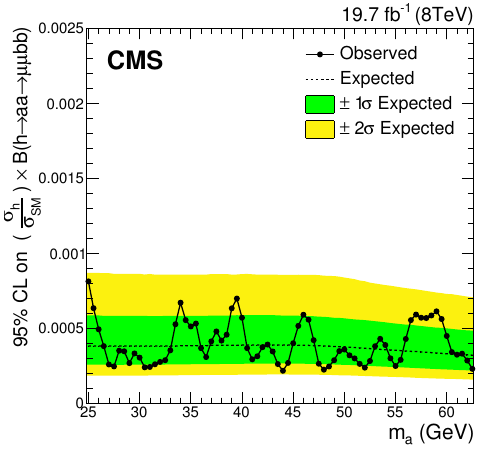
Figure 5 . Observed and expected upper limits at 95% CL on the h boson production normalized to the SM prediction times B (h ! aa ! 2 (cid:22)